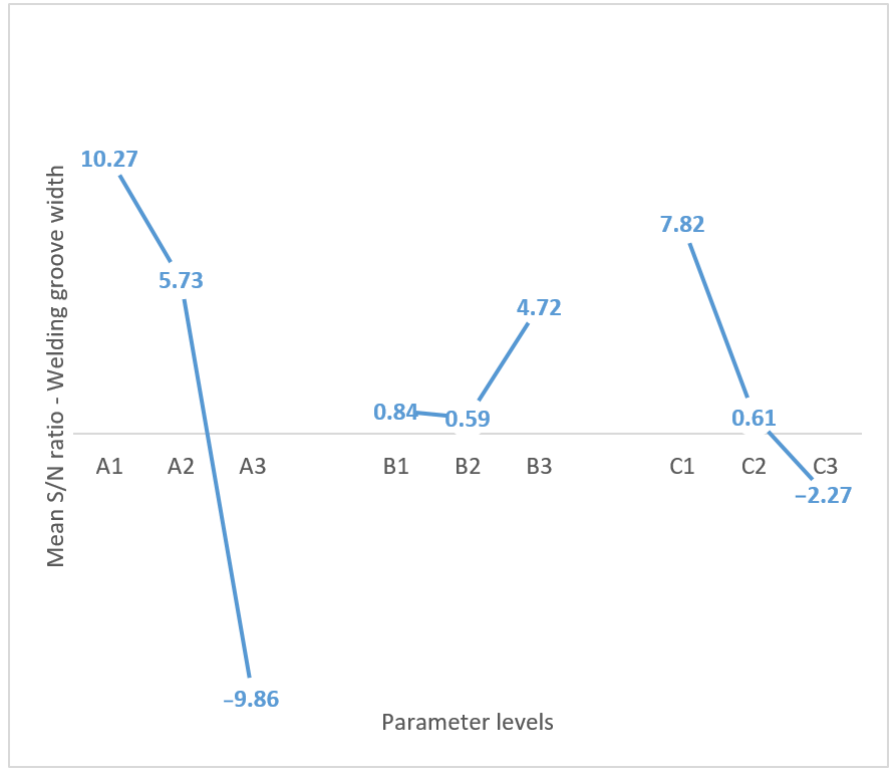
Figure 10. S/N ratio vs. parameter levels for weld bead width. The difference found for the three different levels is notorious. Larger values of S/N ratio identify control factor settings that minimize the effects of noise factors. The same analysis for the width of the weld bead was carried out and the values presented in Table 8 were obtained. The total average of the S/N ratio is 2.05